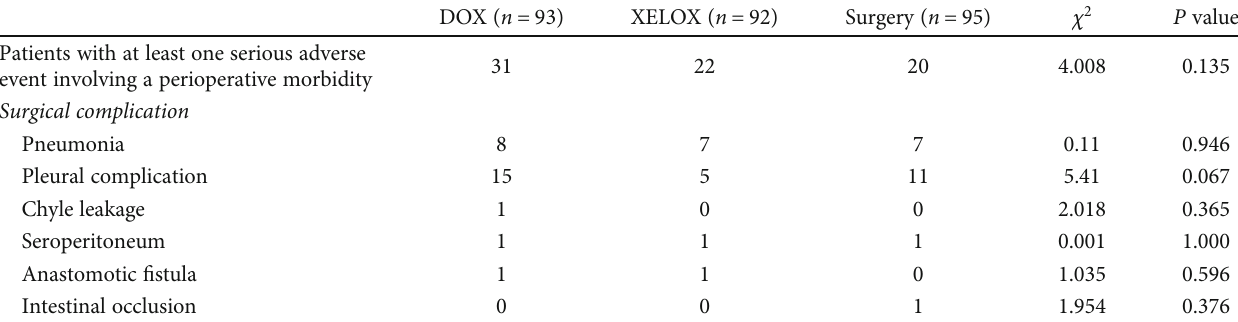
Table 2: Serious adverse events with perioperative morbidity.